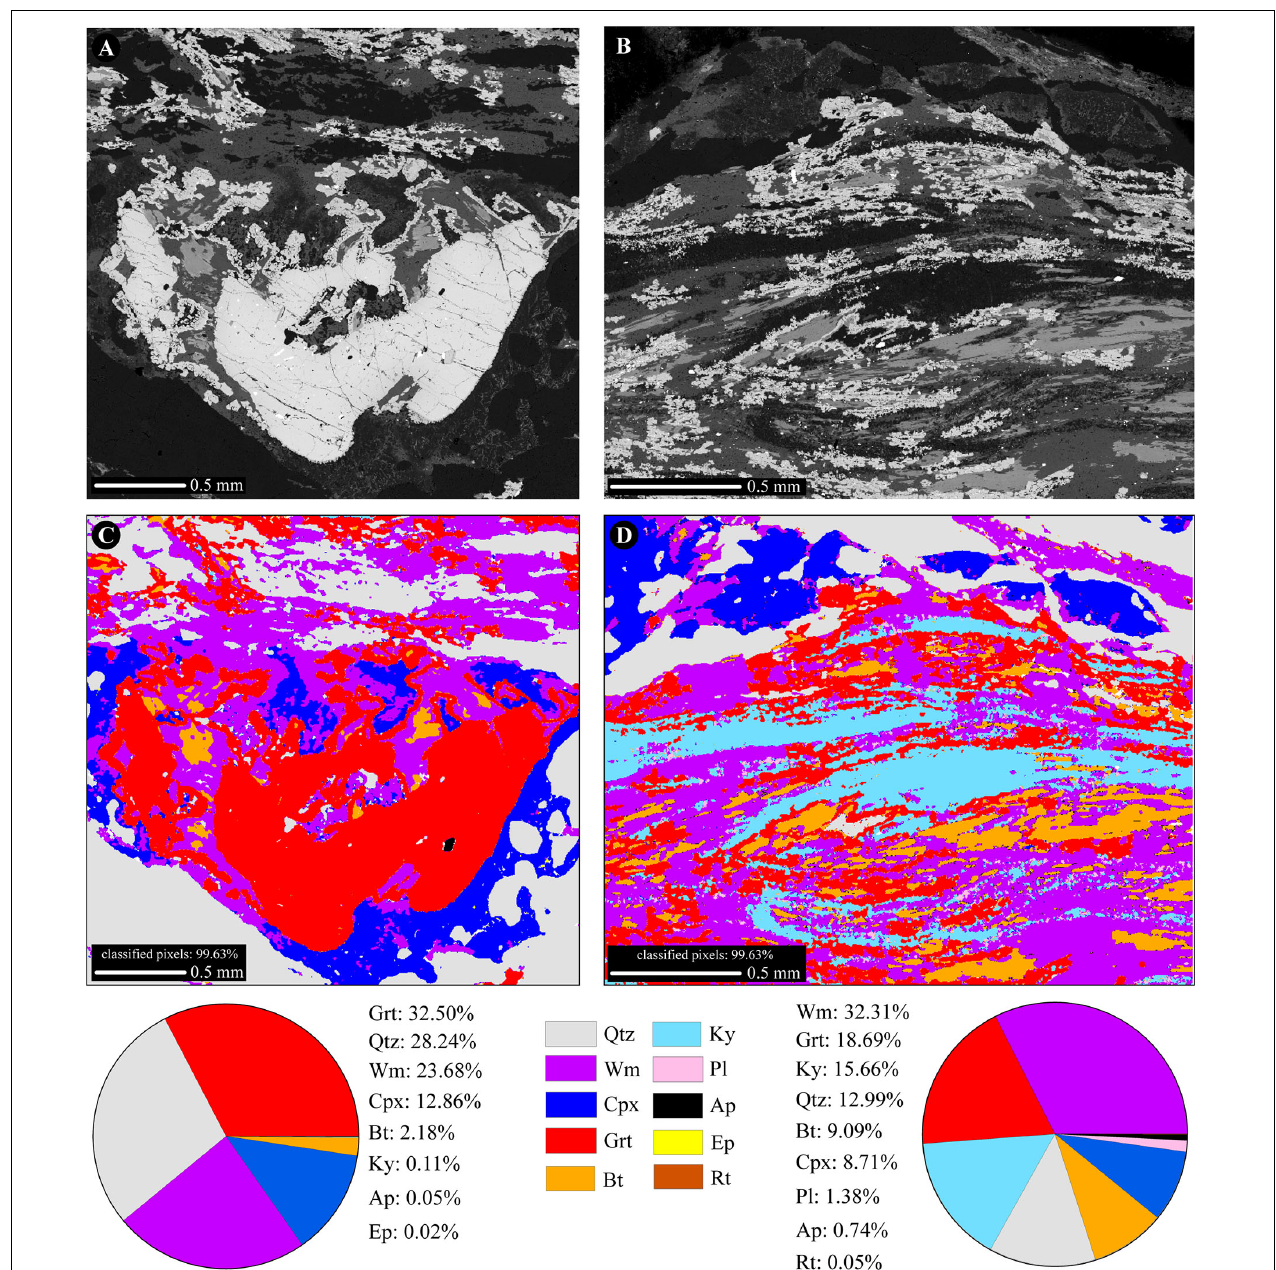
FIGURE 6 | (A) BSE image of pre-alpine Grt microdomain. (B) BSE image of pre-alpine Sill microdomain. (C) Results of Q-XRMA first cycle classification and mineral modal percentage for pre-alpine Grt microdomain. (D) Results of Q-XRMA first cycle classification and mineral modal percentage for pre-alpine Sill microdomain.